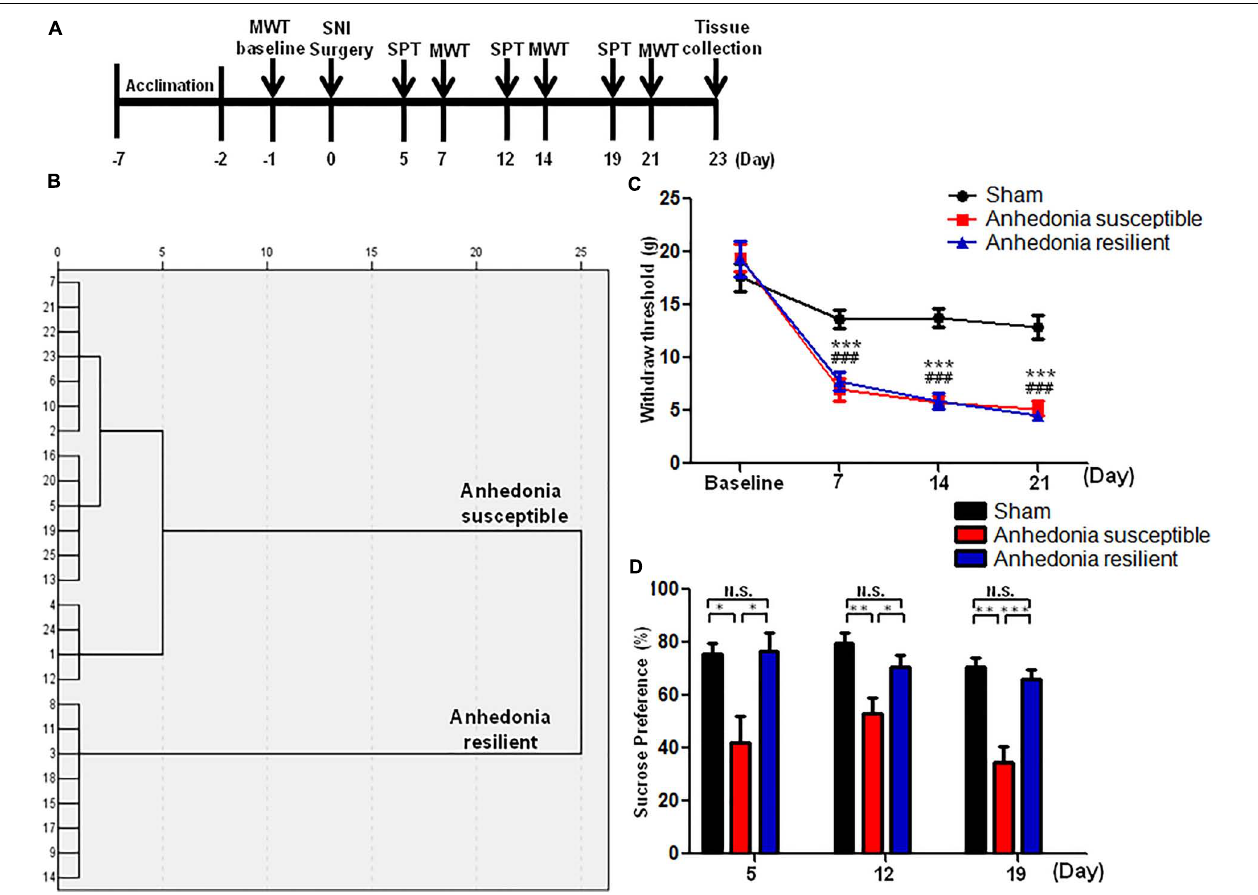
FIGURE 1 | The results of MWT and SPT in sham, anhedonia-susceptible, and anhedonia-resilient rats. (A) The schedule of the experiment. SNI surgery was performed on day 0 after acclimation. MWT was measured on day 7, 14, and 21 after SNI, respectively. SPT was performed on day 5, 12, and 19 after SNI, respectively. (B) Dendrogram of hierarchical clustering analysis. A total of 25 SNI rats were divided into anhedonia-susceptible and anhedonia-resilient groups by SPT results. (C) MWT [Time: F ( 3 , 21 ) = 38.352 , P < 0.001; Group: F ( 2 , 14 ) = 66.232 , P < 0.001; Interaction: F ( 6 , 42 ) = 9.711 , P < 0.001] was measured on day 7, 14, and 21 in the sham, anhedonia-resilient, and anhedonia-susceptible groups after SNI, respectively. Data are shown as mean ± SEM ( n = 8). ∗∗∗ P < 0.001, susceptible group vs. sham group; ### P < 0.001, resilient group vs. sham group. (D) SPT [Time: F ( 2 , 14 ) = 2.523 , P = 0.13; Group: F ( 2 , 14 ) = 30.388 , P < 0.001; Interaction: F ( 4 , 28 ) = 0.687 , P = 0.609] was measured in the sham, anhedonia-resilient, and anhedonia-susceptible groups on day 5, 12, and 19 after SNI, respectively. Data are shown as mean ± SEM ( n = 8). ∗ P < 0.05, ∗∗ P < 0.01, or ∗∗∗ P < 0.001. MWT, mechanical withdrawal test; N.S., not significant; SNI, spared nerve injury; SPT, sucrose preference